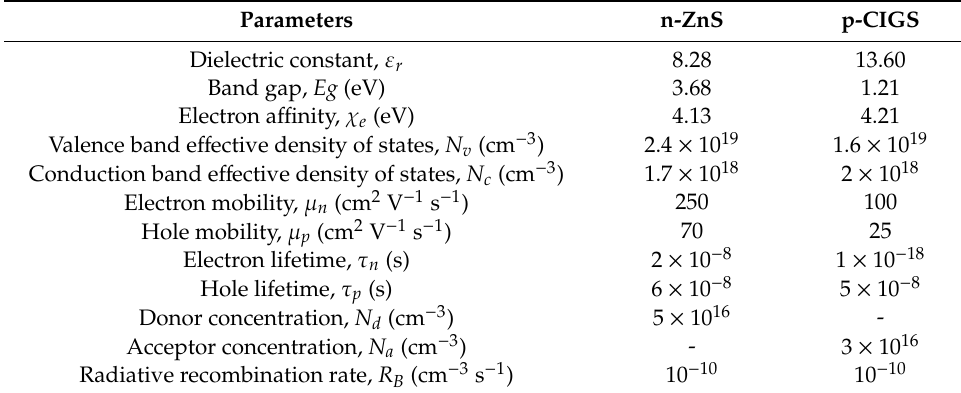
Table 1. Simulation parameters used in the electrical modeling [24].